Question: Judging by this figure, is the value going up or going down?
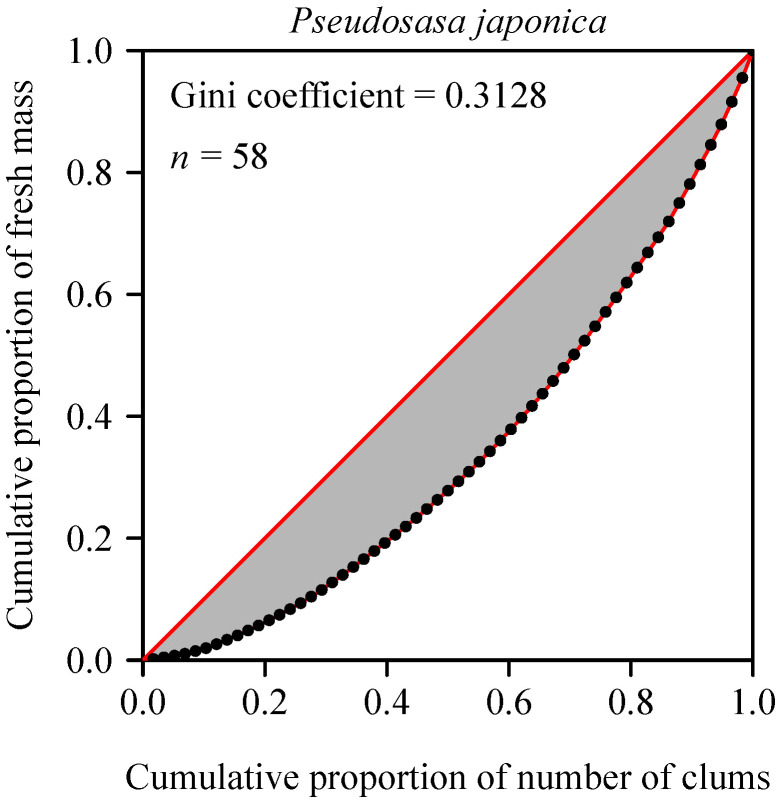
Answer: increasing